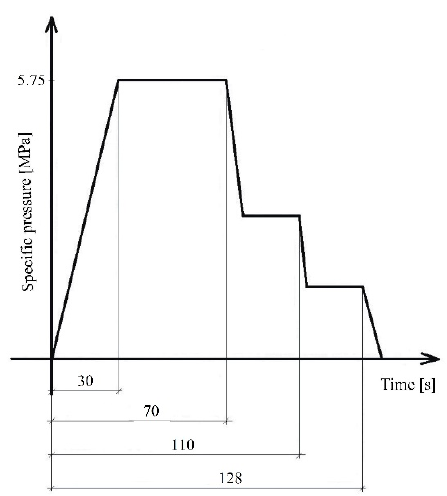
Figure 1. Standard three-stage pressing diagram for the manufacturing of particleboards (PBs). Table 2. Individual types of manufactured particleboards (PBs). Variant